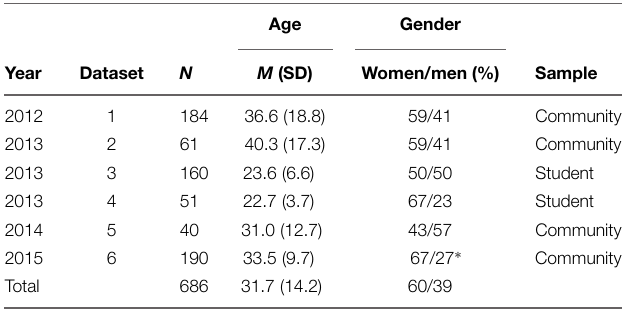
TABLE 1 | Overview of the studies: time, sample size, participants mean age, gender distribution, and type of sample.